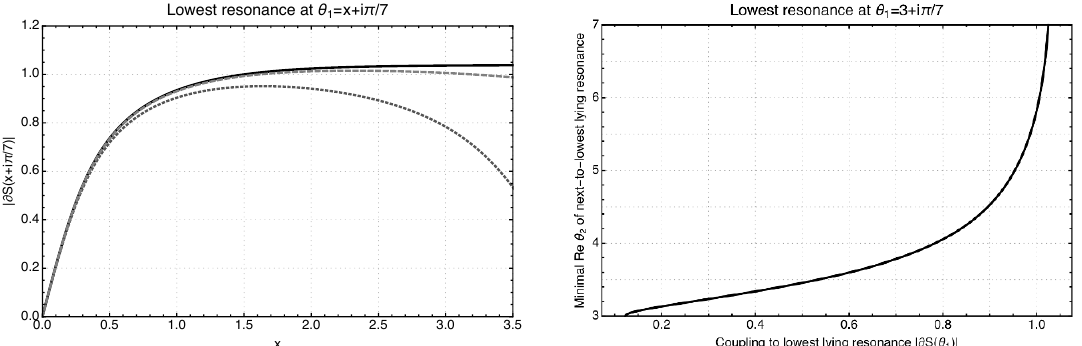
Figure 3 . In the left plot, maximal coupling to the lowest mass resonance at (cid:18) 1 = x + i(cid:25)= 7 for an S -matrix with a single resonance (solid black), and an S -matrix with a second resonance at (cid:18) 2 = 6 + i(cid:25)= 9 (dashed light gray) and (cid:18) 2 = 4 + i(cid:25)= 9 (dotted darker gray). On the right, minimal value of Re (cid:18) 2 as a function of the coupling to the (cid:18) 1 resonance for an S -matrix with two